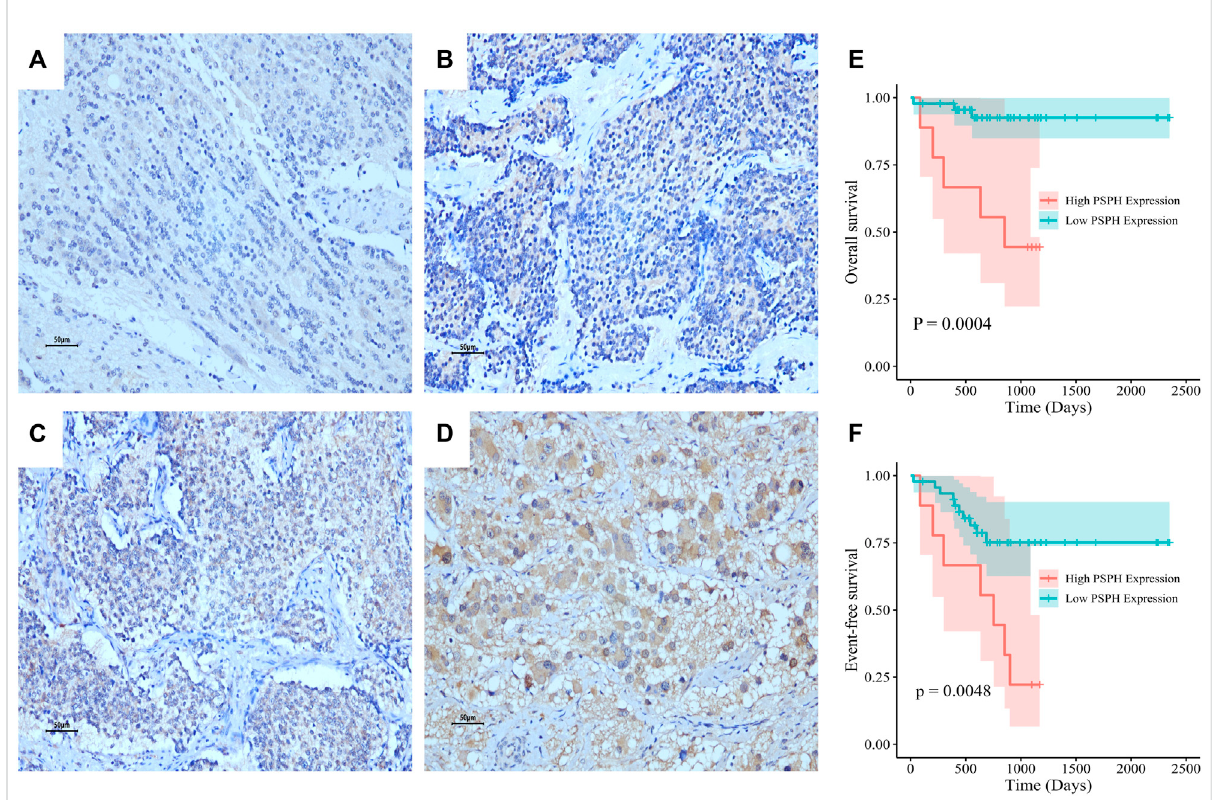
FIGURE 2 PSPHexpressioninNBtissuesamplesandtheassociationwithNBpatients ’ survival.RepresentativeimagesofPSPHexpressiondetectedbyIHC inNBpatients:negative (A) ,weak (B) ,moderate (C) andstrongstaining (D) .TheKaplan-MeiersurvivalofNBpatientswiththehighandlowexpression of PSPH (E) , p = 0.0004 for OS; (F) , p = 0.0048 for